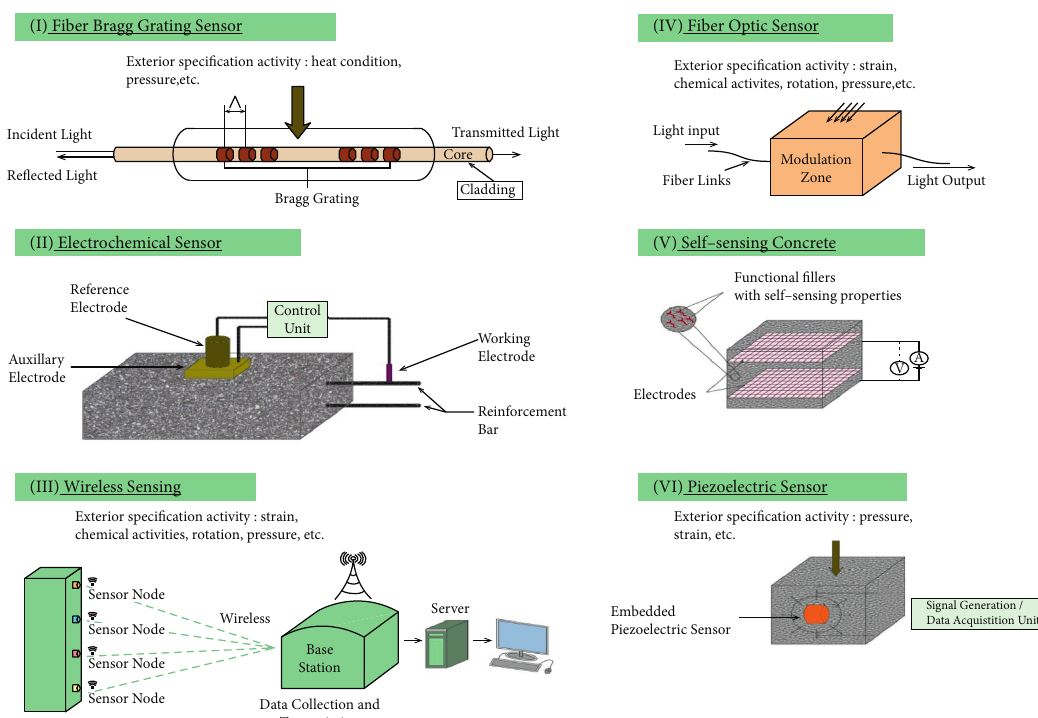
Figure 2: Some of the critical sensors used in structural health monitoring of a civil structure.